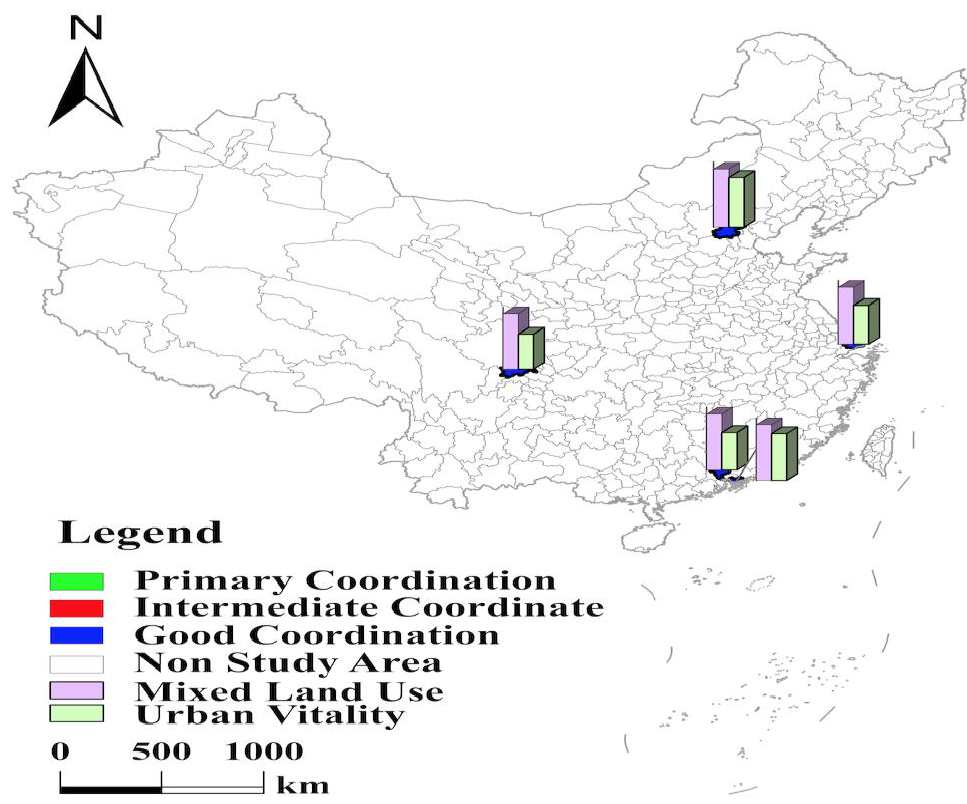
Figure 3. Levels of mixed land use, urban vitality, and coupling coordination in Beijing, Shenzhen, Shanghai, Guangzhou, and Chengdu.